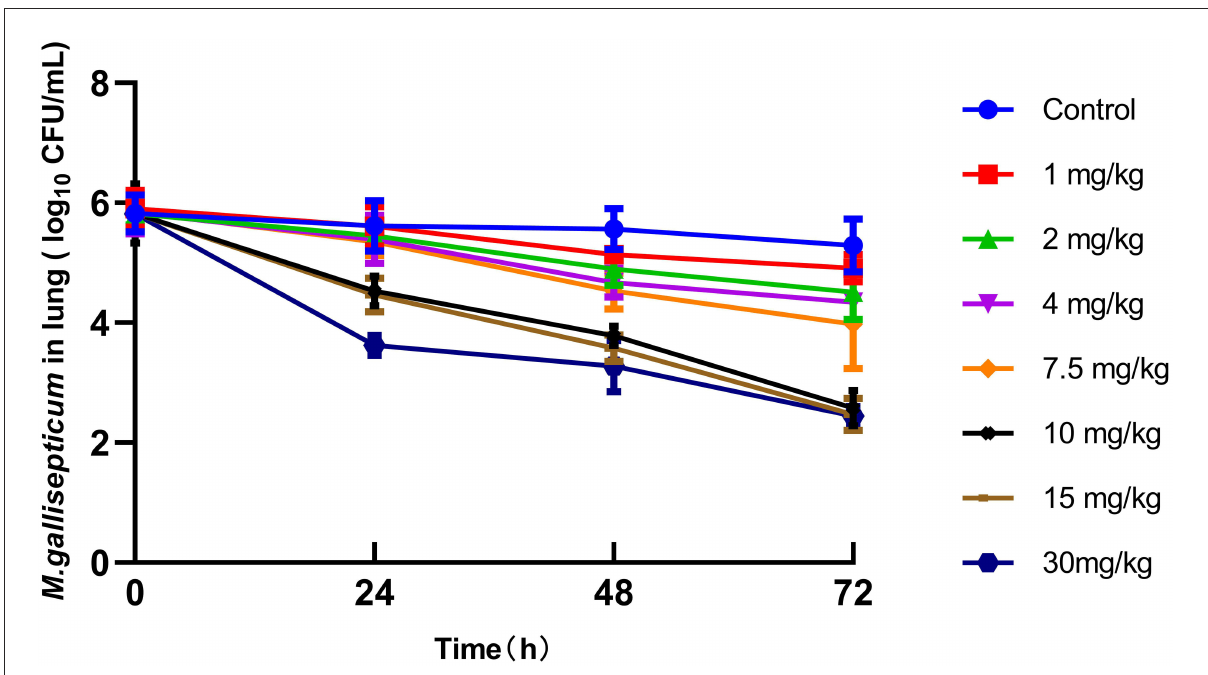
FIGURE4 Viable counts (colony-forming units [CFU]) of M. gallisepticum in lung tissues after different regimens of tilmicosin ( n = 6/time point).